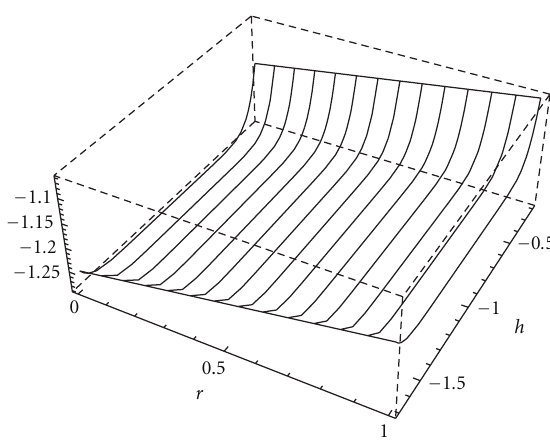
Figure 3: (cid:2) -mesh of ( ∂ 3 /∂t 3 ) Y 10 (0, r